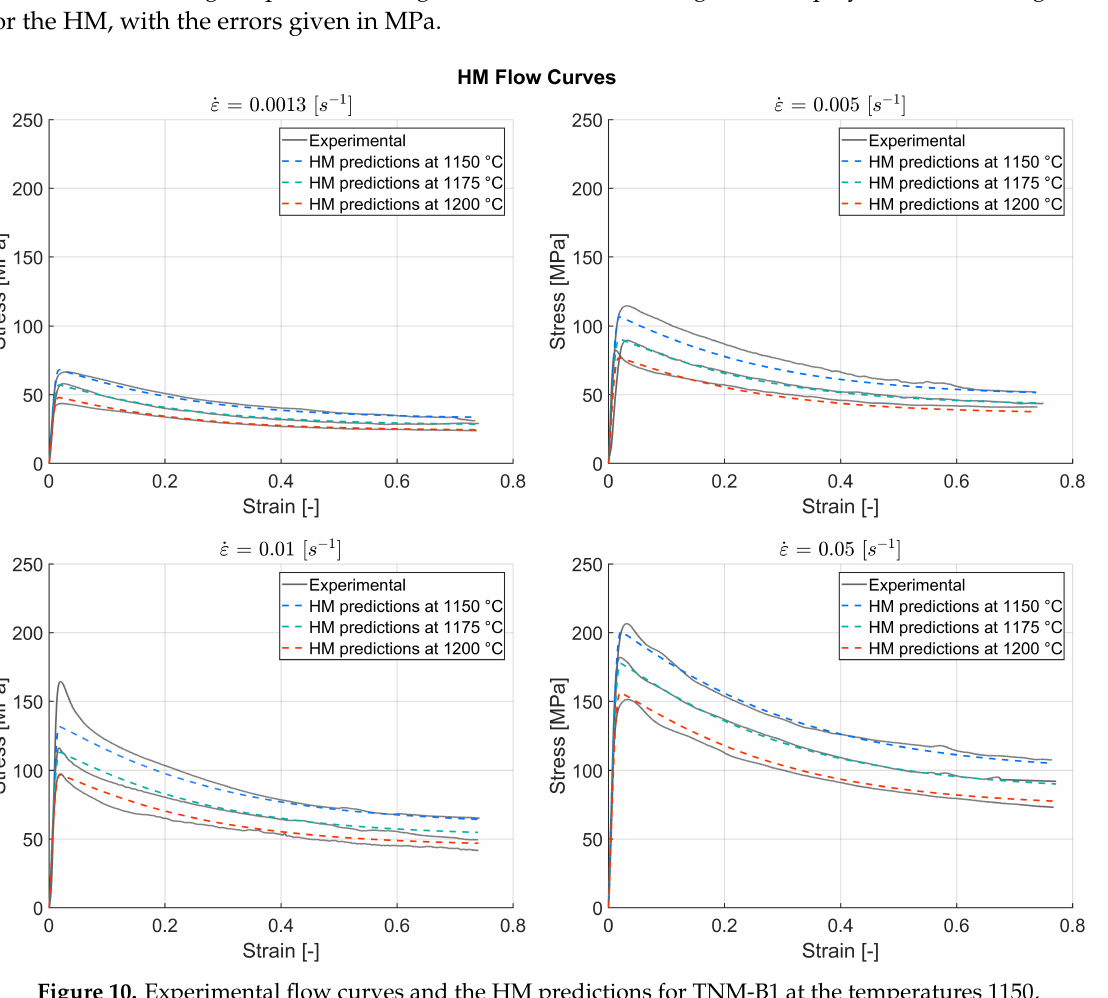
Figure 10. Experimental flow curves and the HM predictions for TNM-B1 at the temperatures 1150, 1175 and 1200 ◦ C and the strain rates 0.0013, 0.005, 0.01 and 0.05 s –1